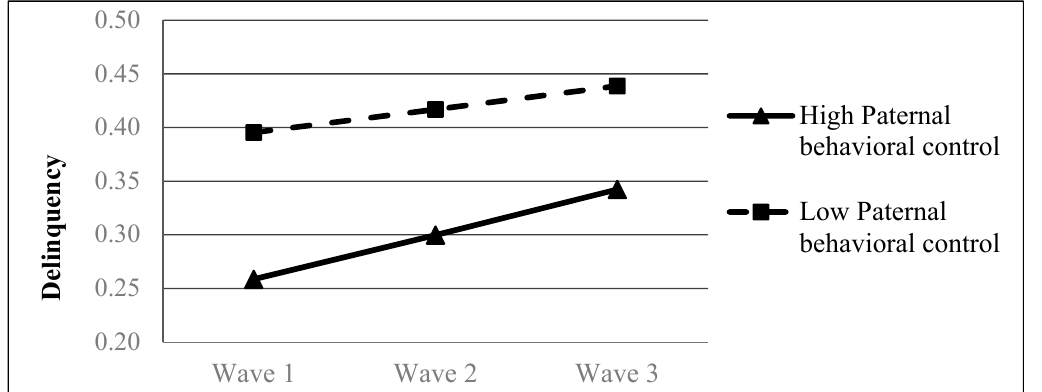
Figure 2. Growth trajectories of adolescent delinquency as a function of paternal behavioral control.